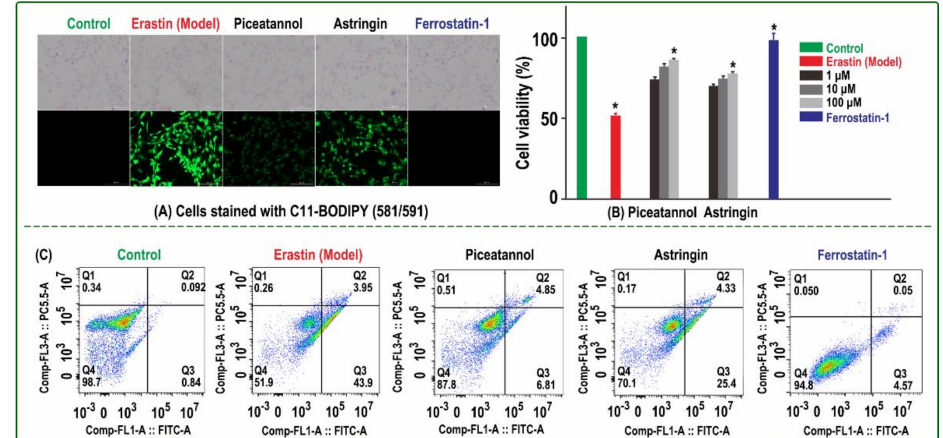
Figure 2. Inhibitory effect of Fer-1, piceatannol, and astringin on erastin-induced ferroptosis in bmMSCs: ( A ) C11-BODIPY assay; ( B ) CCK-8 assay; the control group was cultured in medium only,